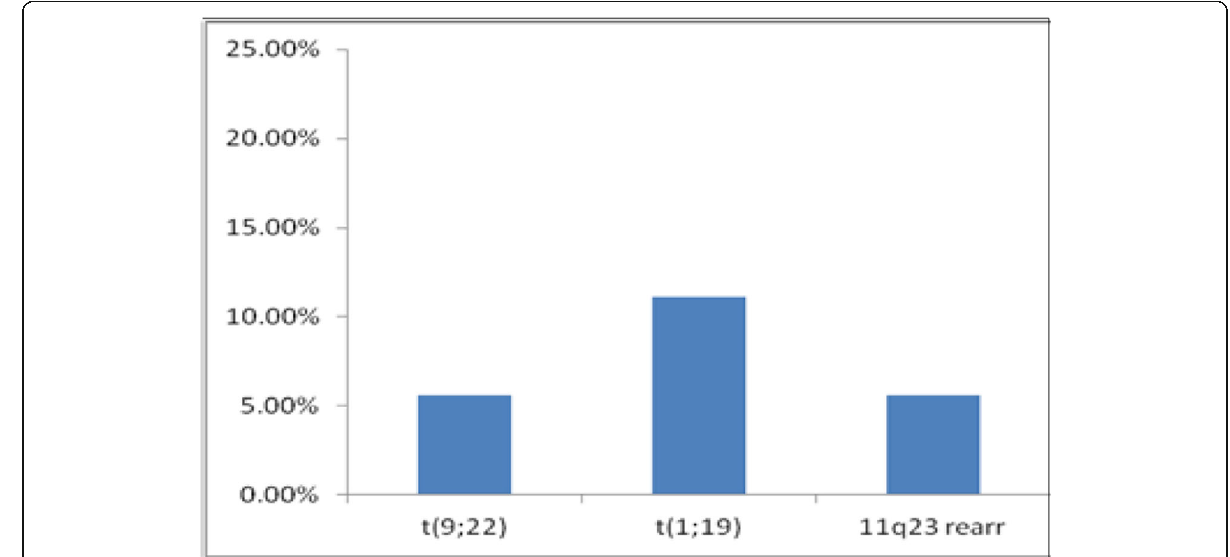
Fig. 1 Percentage of each cytogenetic